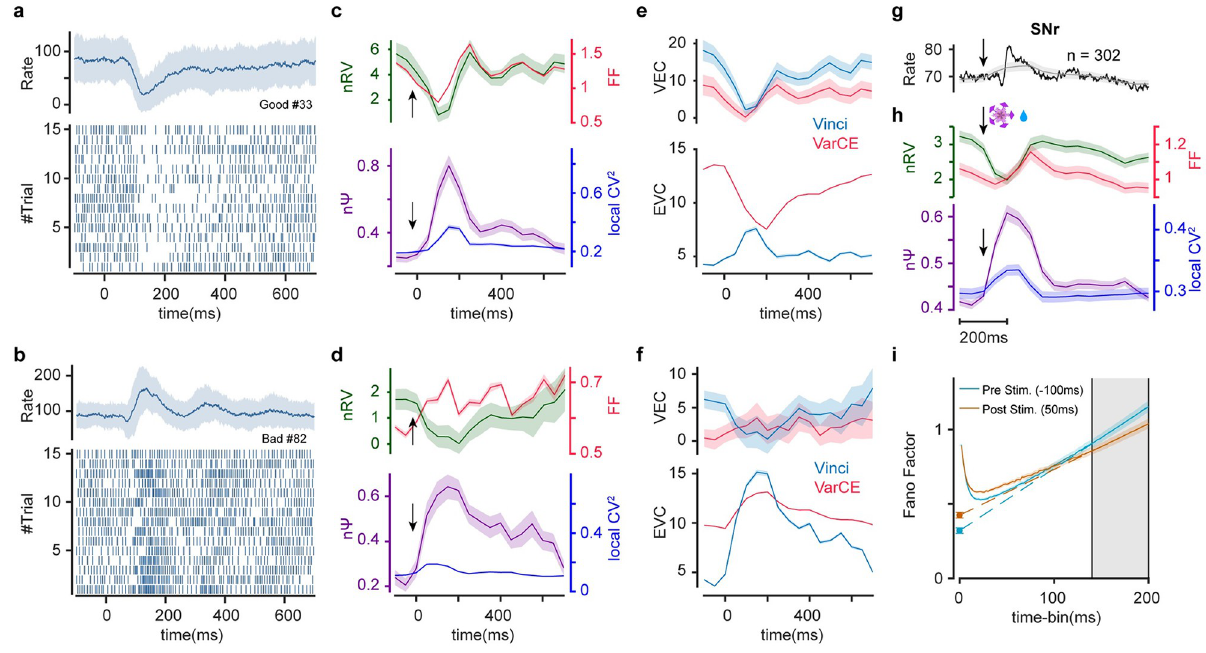
Fig 4. Post-stimulus drop in rate variability is compensated by concurrent rise of spiking irregularity in SNr. (a-f) Same format as Fig 3a and 3c but for one example SNr neuron showing inhibition (a, c, e) and another example SNr neuron showing excitation (b, d, f) to object onset. Raster plots show 15 sample trials for each neuron. (g-i) Same format as Fig 3d and 3f showing population average of 302 SNr neurons. Black and gray traces show PSTHs with 10ms and 200ms bin-widths, respectively. Sliding time-bin of 200ms with 50ms steps were used for estimators of spiking variability.